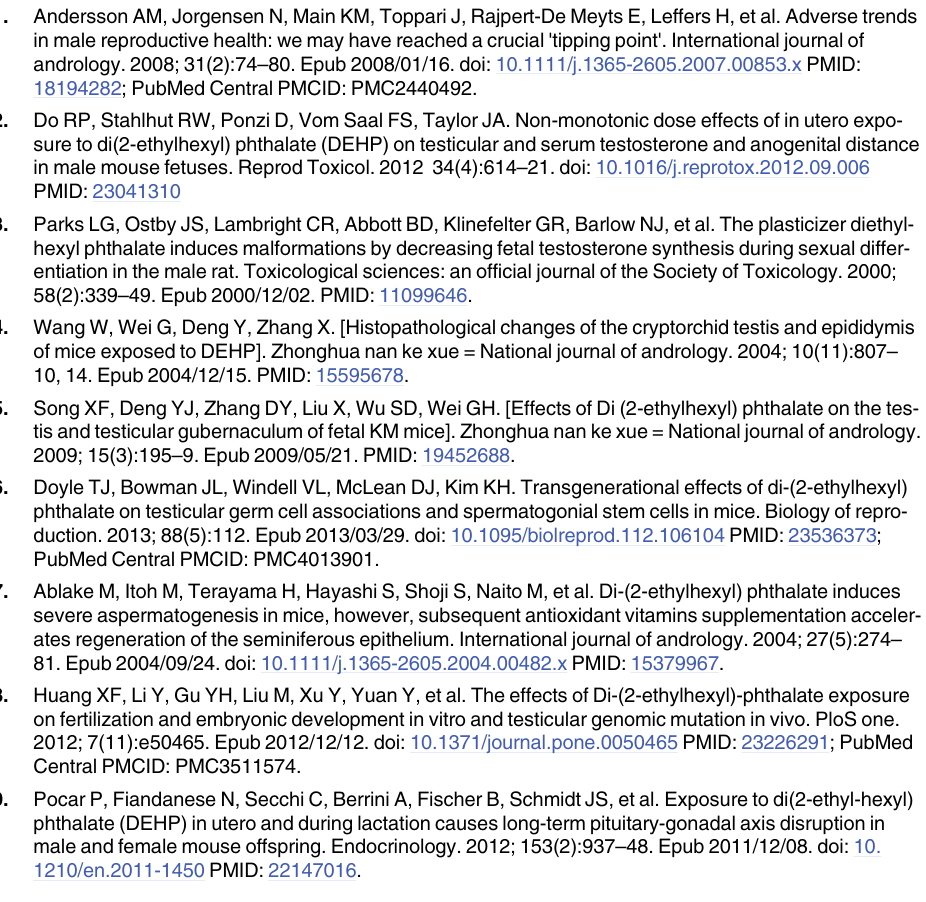
PLOS ONE | DOI:10.1371/journal.pone.0132136 August 5,